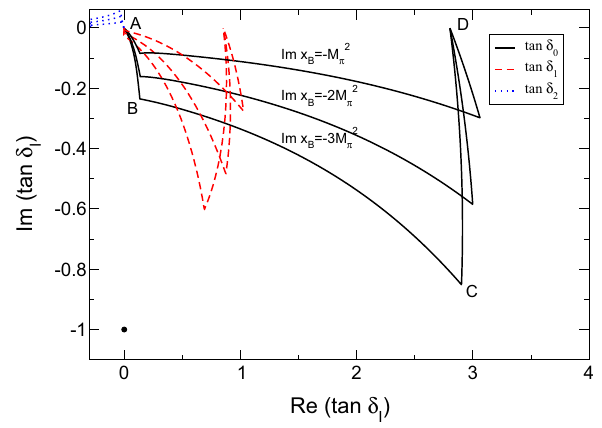
Fig. 8 Real and imaginary parts of tan δ I along the path ABCD, see Fig.1.Im x B denotetheimaginarypartalongthehorizontallineBC.The black dot in the lower left corner denotes the position of the singularity tan δ I = − i (the f 0 ( 500 ) in the case of I = 0 [67,68]). It is seen that the singularity is never hit in the region spanned by the path ABCD with the choice (A.2) for the 4 vertices. Schenk parameterization [66] is used, with parameters from [19], see Appendix